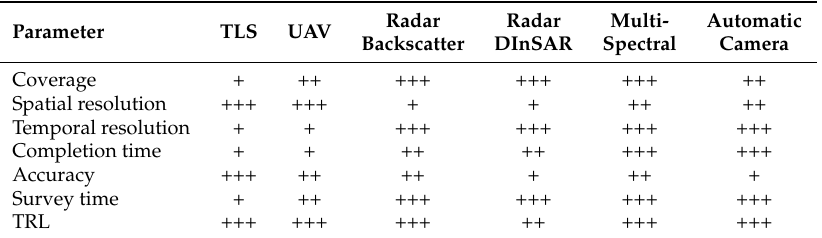
Table 7. Comparison of applied methods for monitoring geomorphological processes in terms of technical specification and quality characteristics: Codes: coverage, spatial extent of dataset; completion time. time period from the survey to the usable dataset; accuracy. both geolocation and pixel value (elevation for TLS and UAV; reflectivity for backscatter; phase for DInSAR reflectivity for multi-spectral; no additional pixel information for automatic camera); TRL, technology readiness level for the application monitoring geomorphic